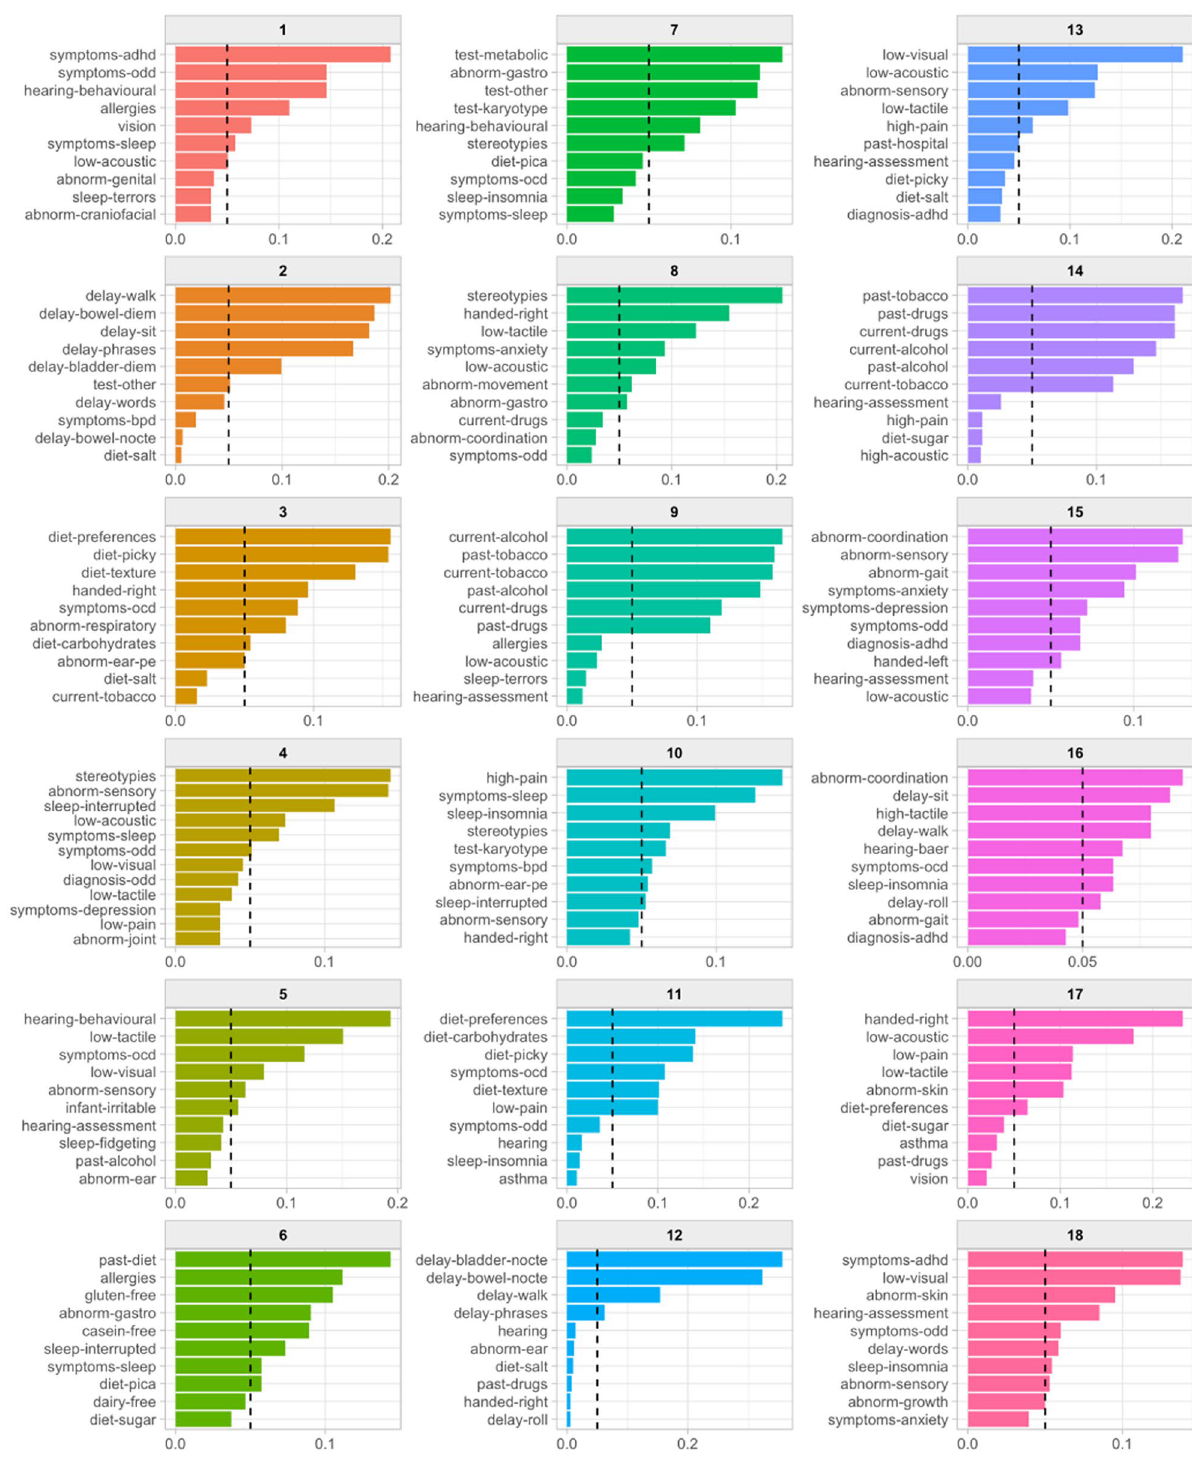
Figure 1. ‘Terms-to-topic’ probabilities for patients with autism spectrum disorder (ASD). The figure illustrates the topics (i.e., clusters of comorbid conditions) and their over-represented terms (i.e., comorbid conditions). Names for each panel indicate the topic number from which associated data are drawn. x -axes indicate beta weights ( β ), signifying the probability of each term falling under the specific topic. y -axes indicate the most probable ( n = 10) terms rank-ordered by β weight. Dashed lines indicate β =